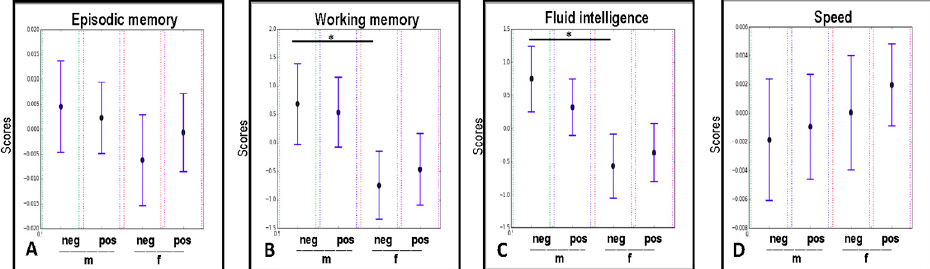
Figure 5. The influence of CMV-serostatus and gender on episodic memory, working memory, fluid intelligence, and processing speed, analyzed with the Bootstrapping approach. * p < 0.05. m: male; f: female; pos: CMV-seropositive; neg: CMV-seronegative.